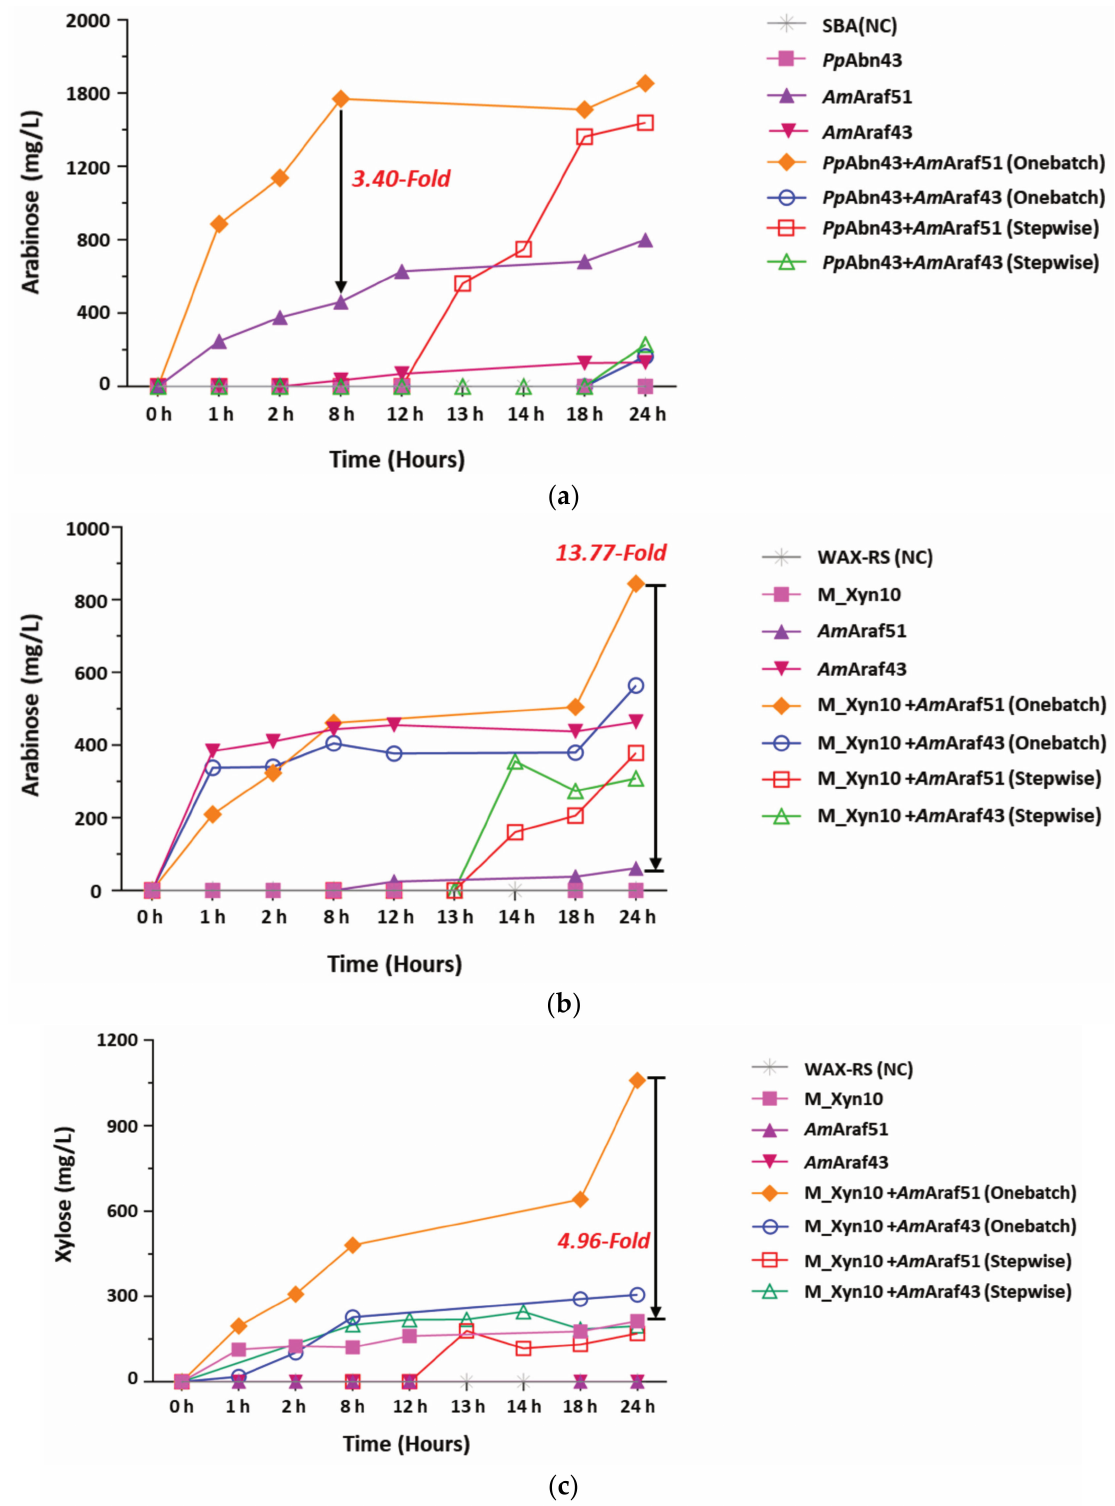
Figure 7. Hydrolysis of 0.5% ( w / v ) sugar beet arabinan (SBA) or wheat flour arabinoxylan (WAX-RS) by different combina- tions of endoactive enzymes (0.90 µ M Pp Abn43 or 2.9 µ M M_Xyn10) and exoactive enzymes (0.3 µ M Am Araf51 or Am Araf43) at 50 ◦ C and pH 5.5 over time. ( a ) Arabinose released from SBA. ( b ) Arabinose released from WAX-RS. ( c ) Xylose released from WAX-RS. The concentrations of arabinose and xylose in the reactions were quantified by HPAEC-PAD